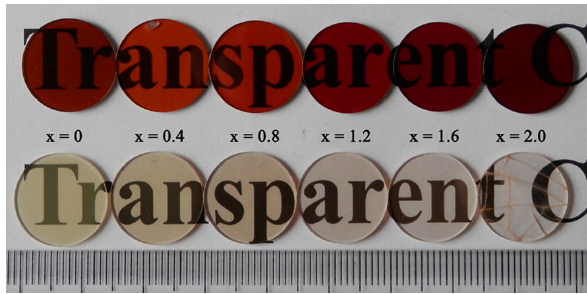
Fig. 16 Photograph of La 1.94– x Gd x Zr 2 O 7 :3at%Eu 3+ ( x = 0–2.0) transparent ceramics before (above) and after (below) annealing. Reproduced with permission from Ref. [53], © John Wiley and Sons 2015.